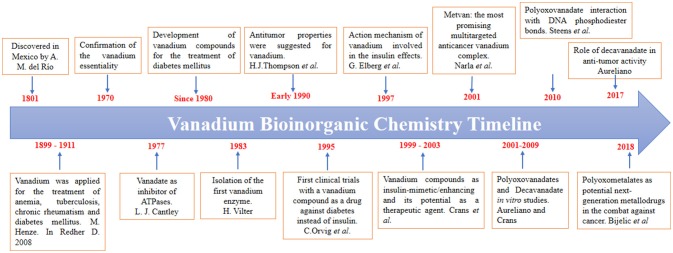
A brief timeline of the vanadium bioinorganic chemistry, highlighting the vanadium role as an antidiabetic, and anticancer agent (Cantley et al., 1977; Thompson et al., 1984; Vilter, 1984; Orvig et al., 1995; Elberg et al., 1997; Crans, 2000; Narla et al., 2001; Rehder, 2008; Aureliano and Crans, 2009; Steens et al., 2010; Aureliano, 2017; Bijelic et al., 2018).